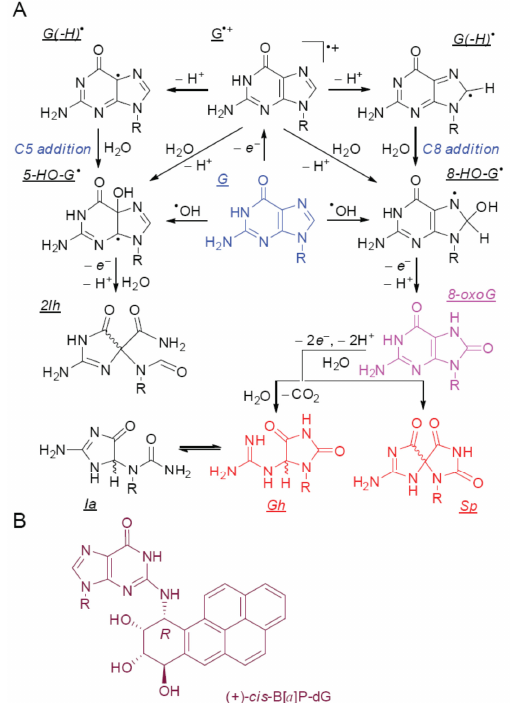
Figure 1. ( A ) Oxidatively generated guanine lesions generated by reactions of strong oxidants or electrophilic free radicals. 8-Oxo-7,8-dehydroguanine (8-oxoG, via C8 addition of H 2 O/ • OH), and 5-carboxamido-5-formamido-2-iminohydantoin (2Ih, by C5 addition of H 2 O/ • OH), whereas end products of a four-electron oxidation are spiroiminodihydantoin (Sp) and 5-guanidinohydantoin (Gh). The two-electron oxidation products are substrates of BER only [29,30], while the four-elec- tron oxidation products are substrates of both BER and NER pathways [14,21,31]. ( B ) The bulky guanine DNA adduct 10 R -(+)- cis-anti -B[ a ]PDE- N 2 -dG is a well-known substrate of NER only [32,33] and is used for comparing the NER yields of oxidative DNA lesions that are substrates of NER and BER. The free radical intermediates, the guanine radical cation (G •+ ) and the neutral gua- nine radical [G(-H) • ] are highly reactive, and are rapidly hydrated via the addition of H 2 O hydroxyl radicals to the C8 and C5 positions, are reducing agents. These intermediates are rapidly oxidized by O 2 or other relatively weak oxidants, to form two stable end-prod- ucts of two-electron oxidation, 8-oxo-7,8-dehydroguanine (8-oxoG) and 5-carboxamido-5-